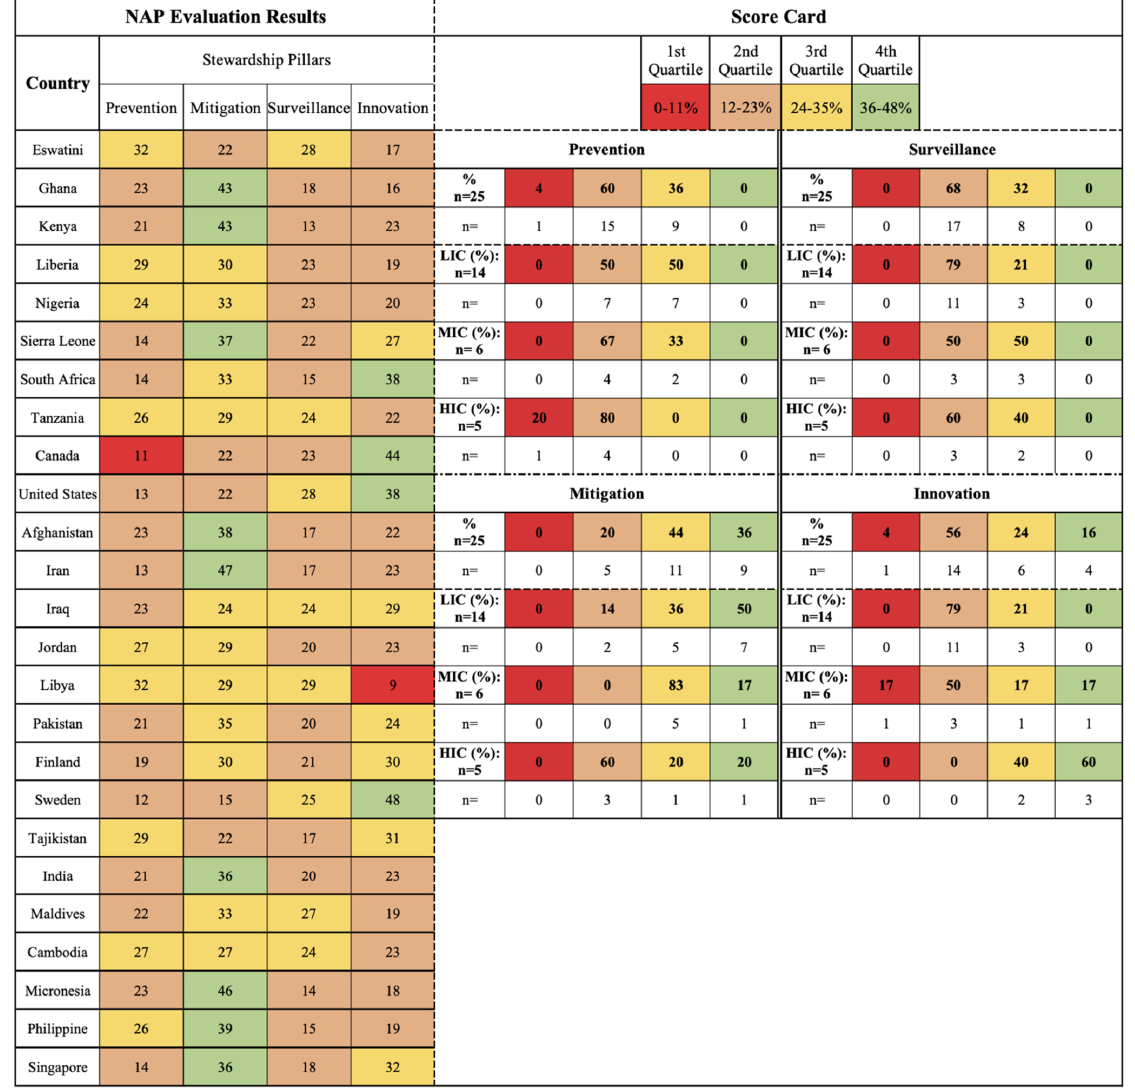
Figure 10. Stewardship pillars (mitigation, innovation, prevention, surveillance) scorecard by country and income level.